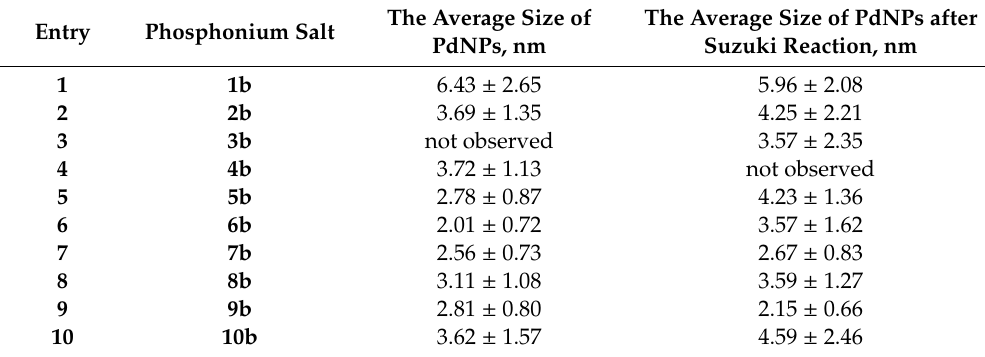
Table 2. The average size of PdNPs before and after Suzuki reaction.